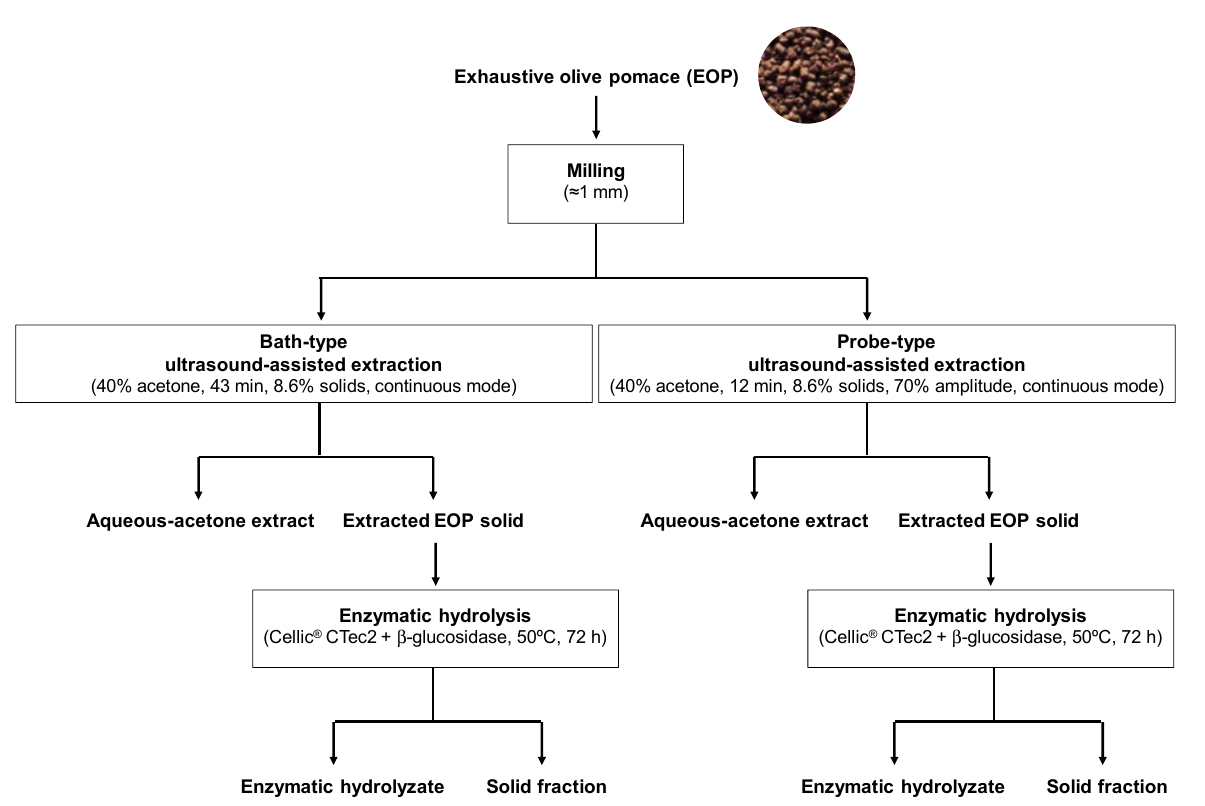
Figure 1. Scheme summarizing the procedures used and samples obtained in this work.